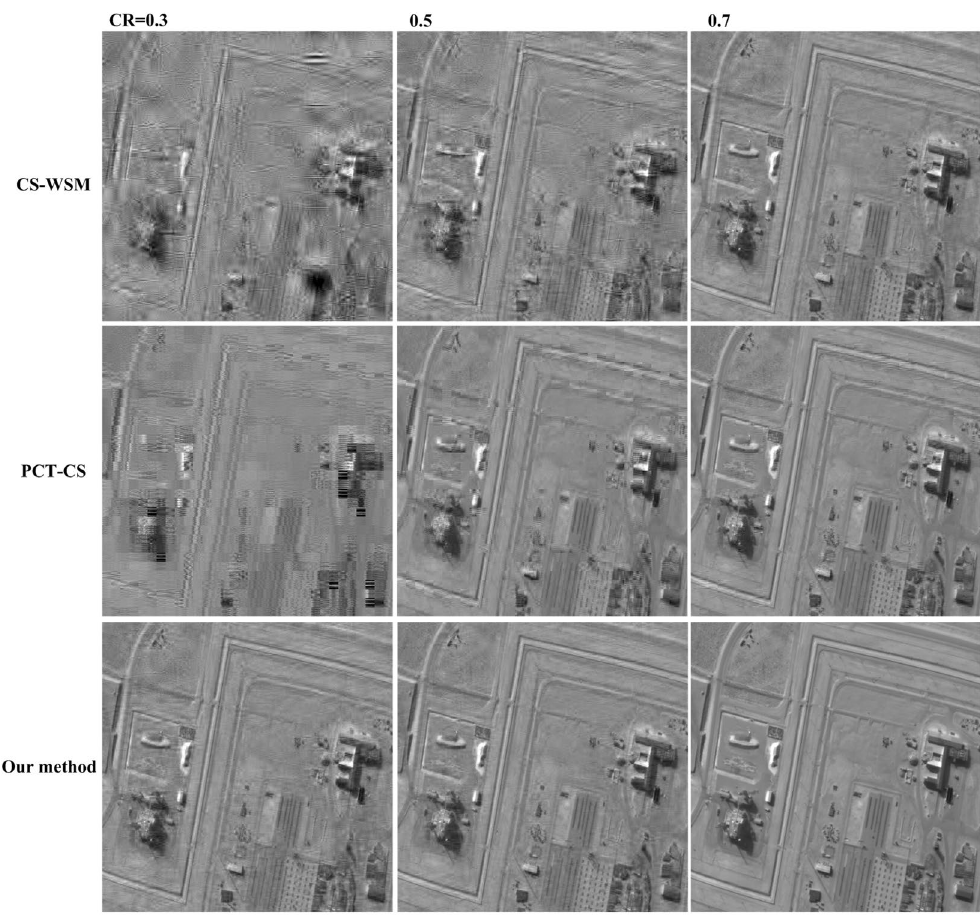
Figure 4. Reconstructed images obtained using different methods at different CR values.